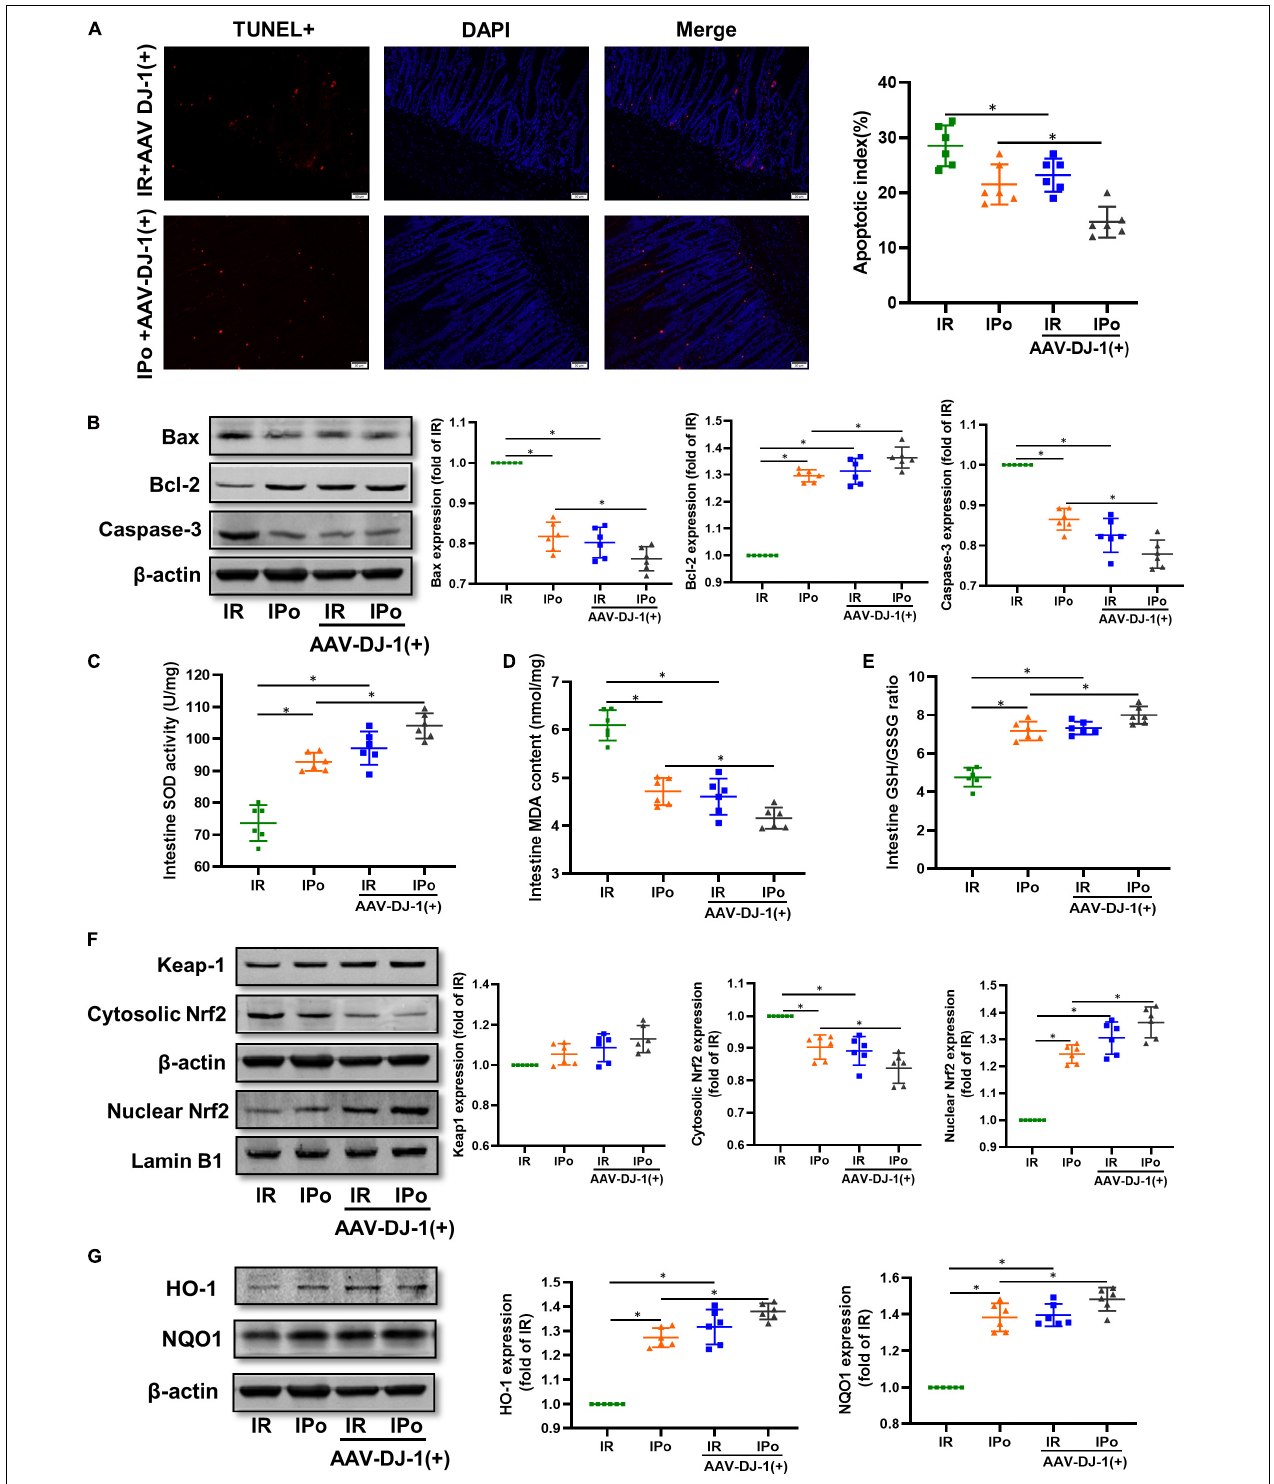
FIGURE 6 | Overexpression of DJ-1 promoted IPo-induced protection via ameliorated myocardial IR-induced apoptosis and suppressed oxidative stress by regulating Nrf2 pathway. (A) The TUNEL staining for cell apoptosis rates. (B) Expression of apoptosis-related proteins Bax, Bcl-2, and caspase-3. (C) SOD. (D) MDA. (E) GSH/GSSG ratio. (F) Expression of Keap-1 and Nrf2 in the cytosolic and nucleus, (G) Expression of HO-1 and NQO1. Lamin B1 and β -actin were detected as loading controls, respectively, and β -actin gel is the same as in Figure 5 . S, Sham; IR, ischemia reperfusion; IPo, ischemic postconditioning. Data are presented as the mean ± SD ( n = 6). * P <